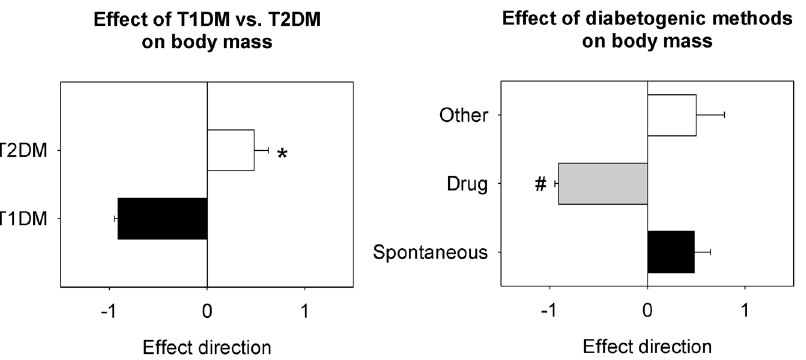
Figure 3. Effect of diabetes type and methods of diabetogenicity on body weight in experimental rodent models of diabetes. The type of diabetes and the method of inducing diabetes significantly affect final body weight in rodent models of diabetes. * significant effect of diabetes type; # significant effect of diabetogenic from both other categories. Significance set at P , 0.05. T1DM = type 1 diabetes mellitus; T2DM = type 2 diabetes